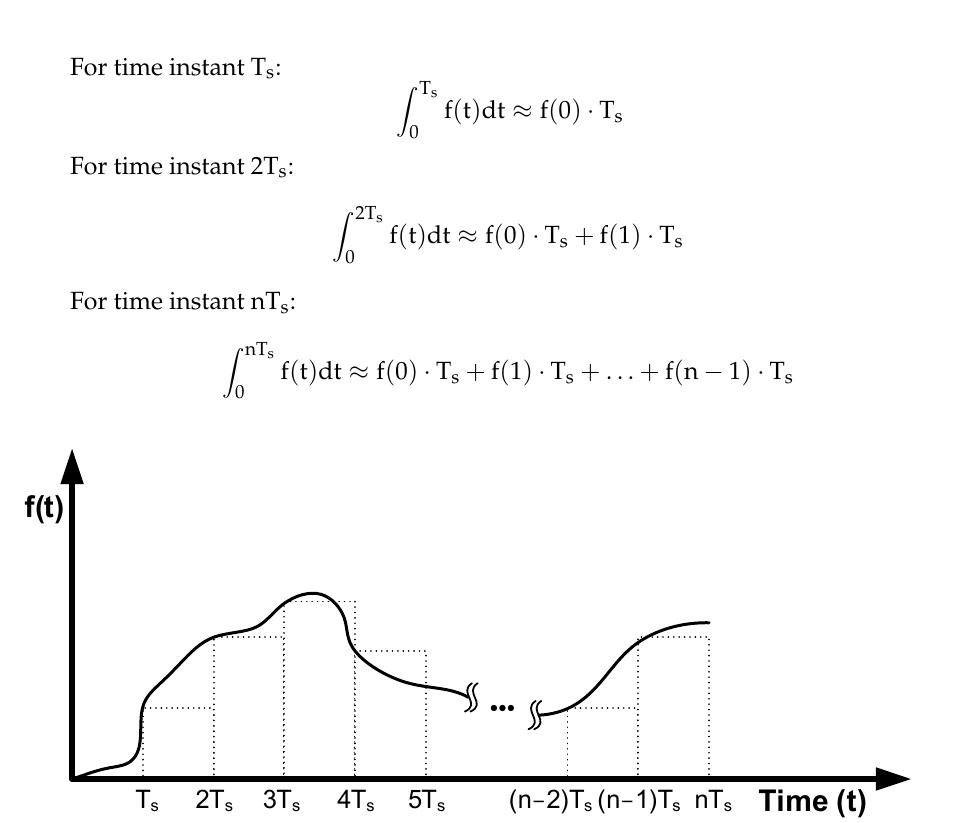
Figure 5. Approximating an integral by summation.